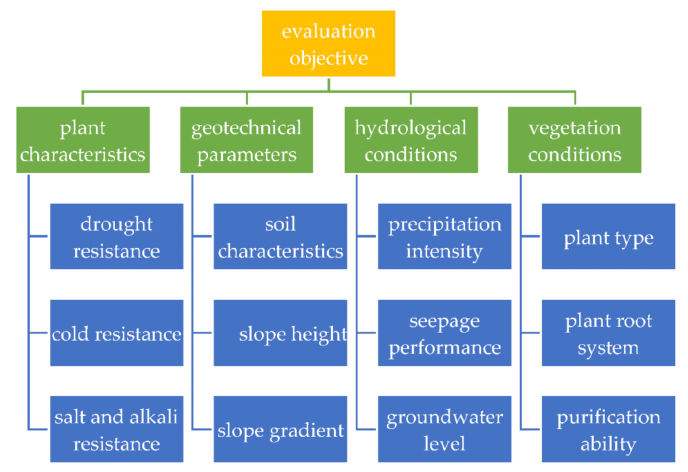
Figure 2. Performance evaluation index system of highway plant